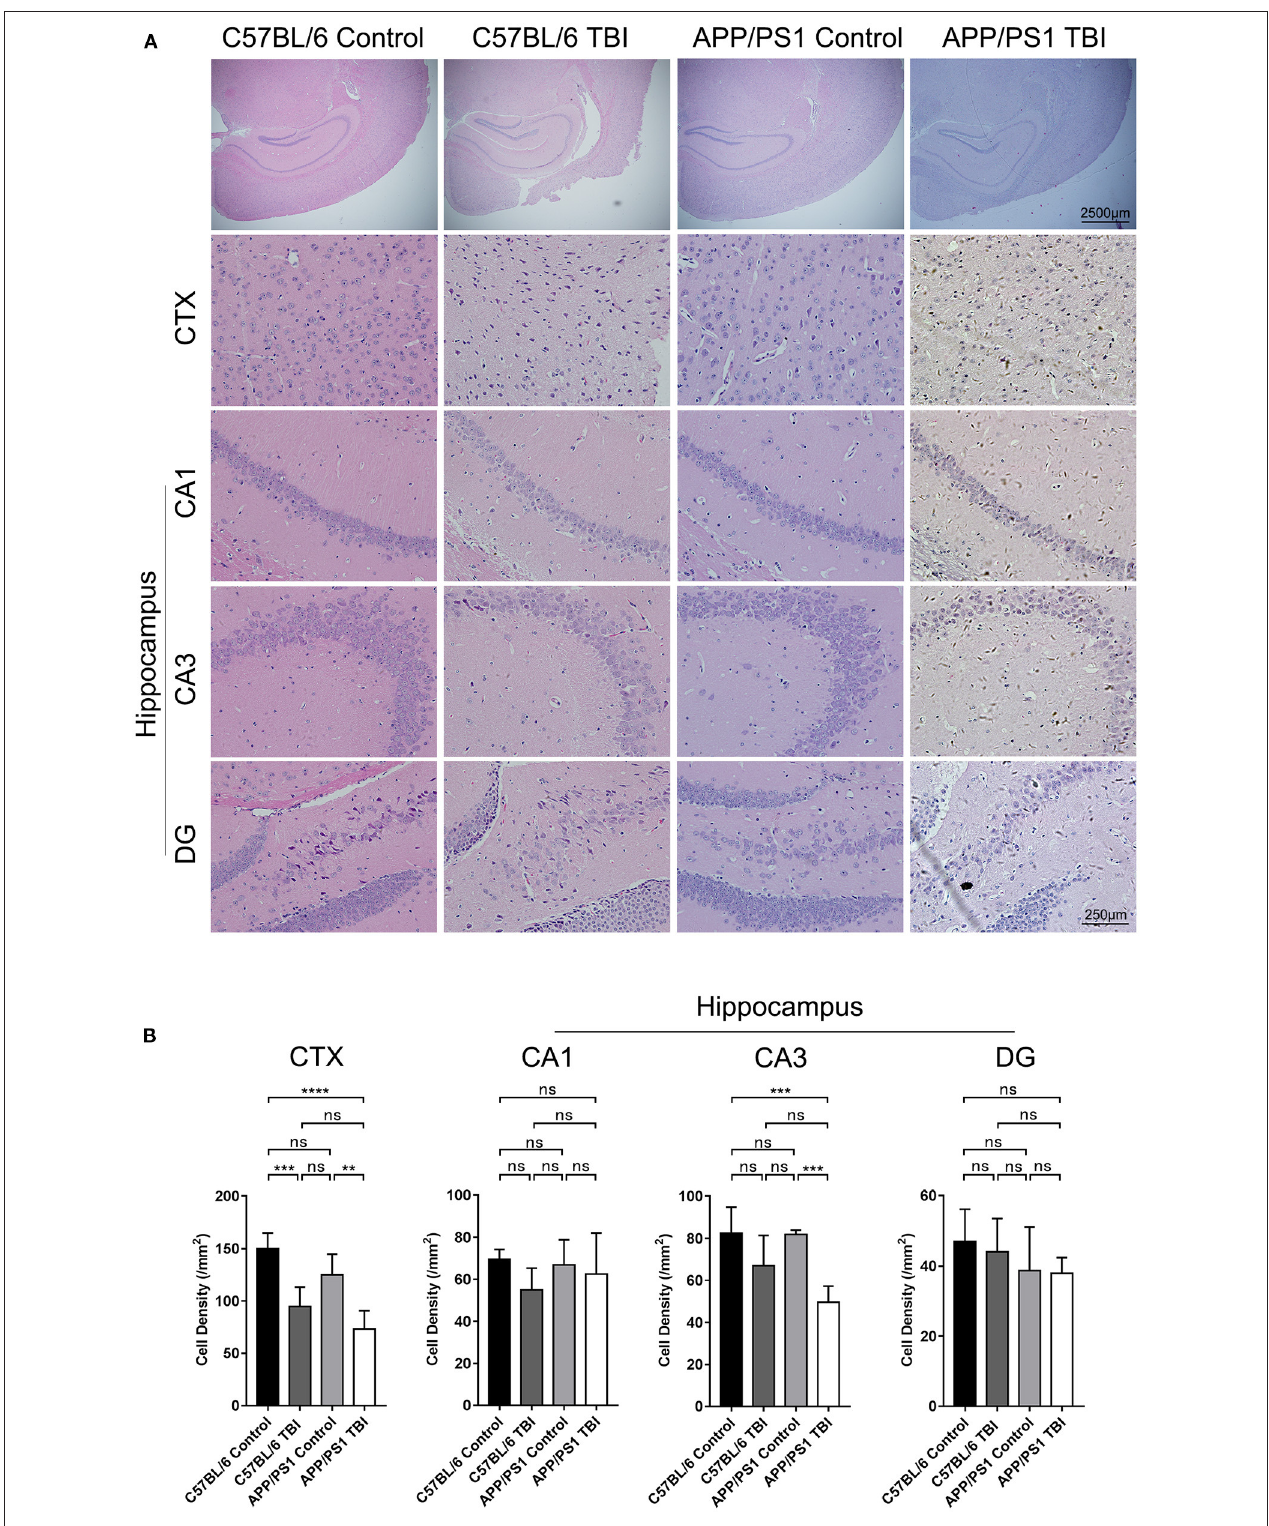
FIGURE 2 | Cell density in the CA3 region of the hippocampus in APP/PS1 mice decreased after TBI. (A) Photographs of HE staining of cortical and hippocampal (CA1, CA3, and DG) tissues from C57BL/6, C57BL/6 TBI, APP/PS1, and APP/PS1 TBI group mice. (B) Cell density in the cortex and hippocampus (CA1, CA3, and DG) in C57BL/6, C57BL/6 TBI, APP/PS1, and APP/PS1 TBI group mice. The error bars represent the SEM ( n = 8/group). ns, non-significant; ** p < 0.01; *** p < 0.001.